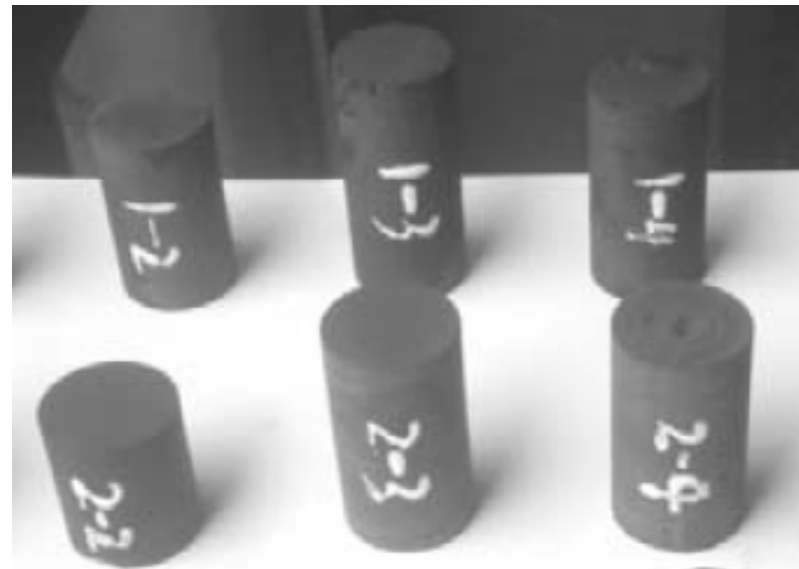
Figure 5. Processed core samples for the rock mechanical tests.